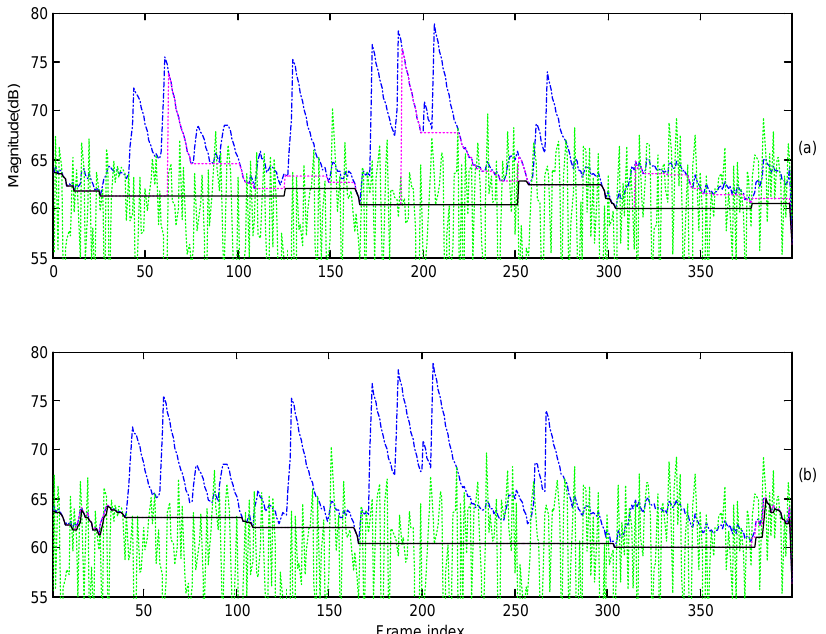
Figure 1. Contour of estimated minimum power. ( a ) Minimum power estimated by the MCRA noise estimator for a sub-band (solid: minimum power, green dotted: true noise power, blue dotted: temporary power, dash dot: local power), spoken by a female speaker, interfered by white noise with an average SegSNR = 10 dB); ( b ) Minimum power estimated by the proposed noise estimator.